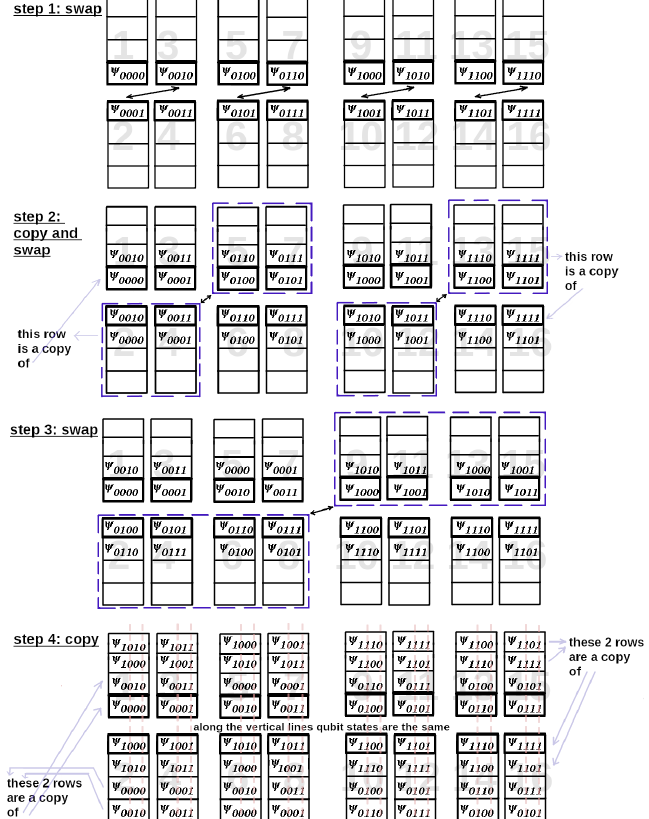
Figure 6. Using the parallelisation scheme of computation of Edwards-Anderson model to simulate the 2-qubit quantum operator ˆ A acting on the 4-qubit quantum scheme. We have 4 steps with 3-fold data exchange and 2-fold data copying. The arrows denote the directions in which the components of (cid:126) Ψ move. The large numbers indicate the memory locations. In steps 2 and 4 we copy pairs of states to transmit them further. Eventually we have all 4 input components of (cid:126) Ψ to apply ˆ A to them. ˆ A is given so that it acts only on qubit 2 and 4. We can make sure that by copying the pairs in steps 2 and 4 we get exactly necessary 4 components with the different states of the qubits 2 and 4 and the same states of the qubit 1 and 3 in each of the 4 components. To copy the data, we allocate the extra memory to store the 4 variables for each component. Some of the memory cells are unoccupied at the beginning. Therefore we see the empty cells at the